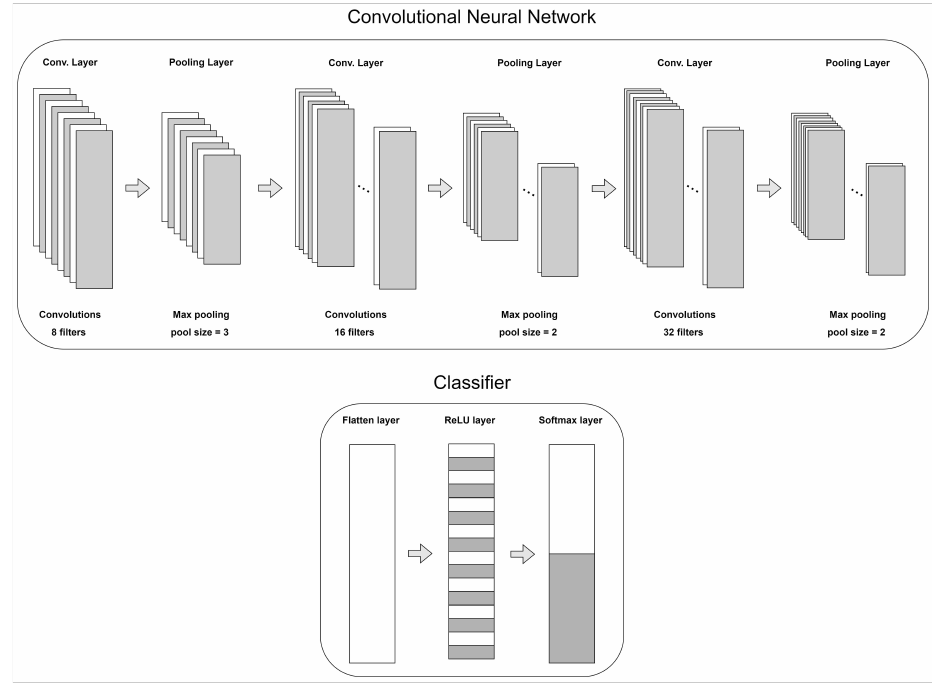
Figure 4. Architecture of the CNN used for the valence and arousal classification.